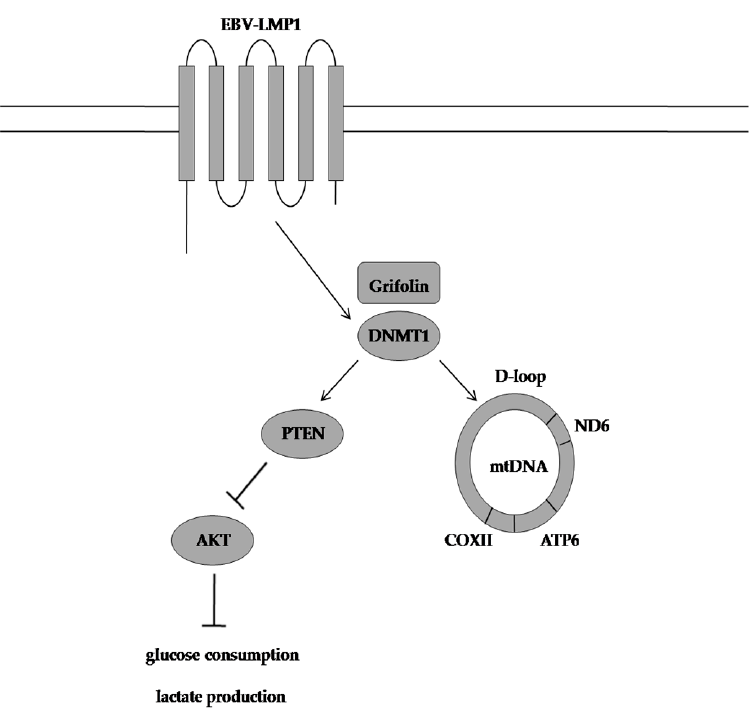
Figure 6. Grifolin-induced mode of action. Grifolin restores oxidative phosphorylation in nasopharyngeal carcinoma cells by reactivating the PTEN gene and reducing the M/U ratio of the mitochondrial DNA D-loop region. EBV-LMP1: Epstein-Barr virus latent membrane protein 1, DNMT1:DNA methyltransferase 1, PTEN: phosphatase and tensin homolog, AKT:protein kinase B, COXII cytochrome oxidase subunit II, ATP6:ATP synthase membrane subunit 6, ND6:NADH ubiquinone oxidoreductase core subunit 6, M/U ratio:methylation and unmethylation